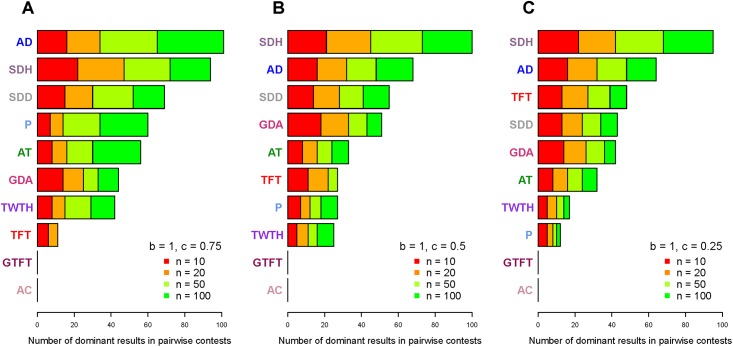
The number of dominant results for nine strategies tested in pairwise contests.AC stands for always-cooperate. AD stands for always-defect. AT stands for always-trembling. TFT stands for tit-for-tat. GTFT stands for generous tit-for-tat. TWTH stands for TFT-with-trembling-hand. SDH stands for shame-driven-hiding. SDD stands for shame-driven-denying. GDA stands for guilt-driven-amending. P stands for Pavlov. (A) When b = 1 and c = 0.75, the ranking of nine strategies. (B) When b = 1 and c = 0.5, the ranking of the strategies. (C) When b = 1 and c = 0.25, the ranking of nine strategies.